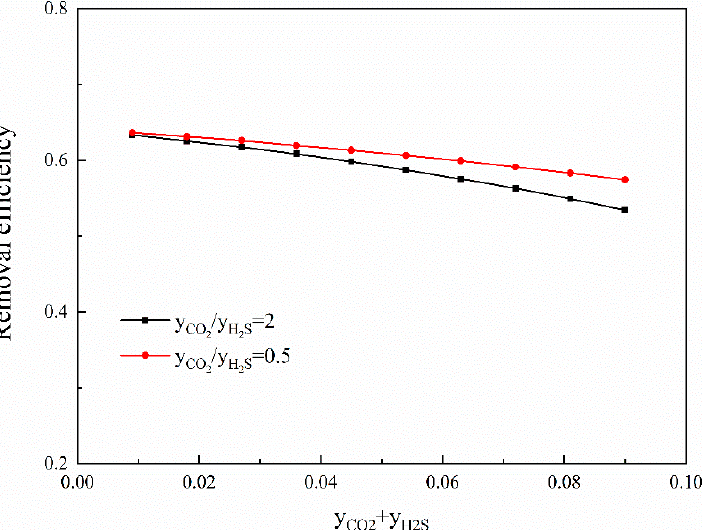
Figure 15. The effect of acid component content in feed gas on the removal efficiency of CH 3 SH (number of plates: 25; overflow weir height: 0.15 m; absorption pressure: 6 Mpa; inlet gas flow rate: 5.0 × 10 6 Nm 3 /d; and inlet gas–liquid ratio: 600).